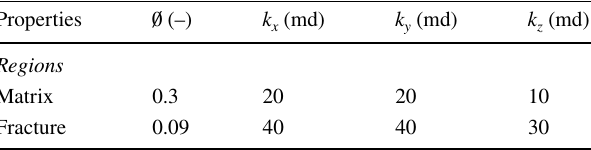
Table 3 Reservoir properties of case #1